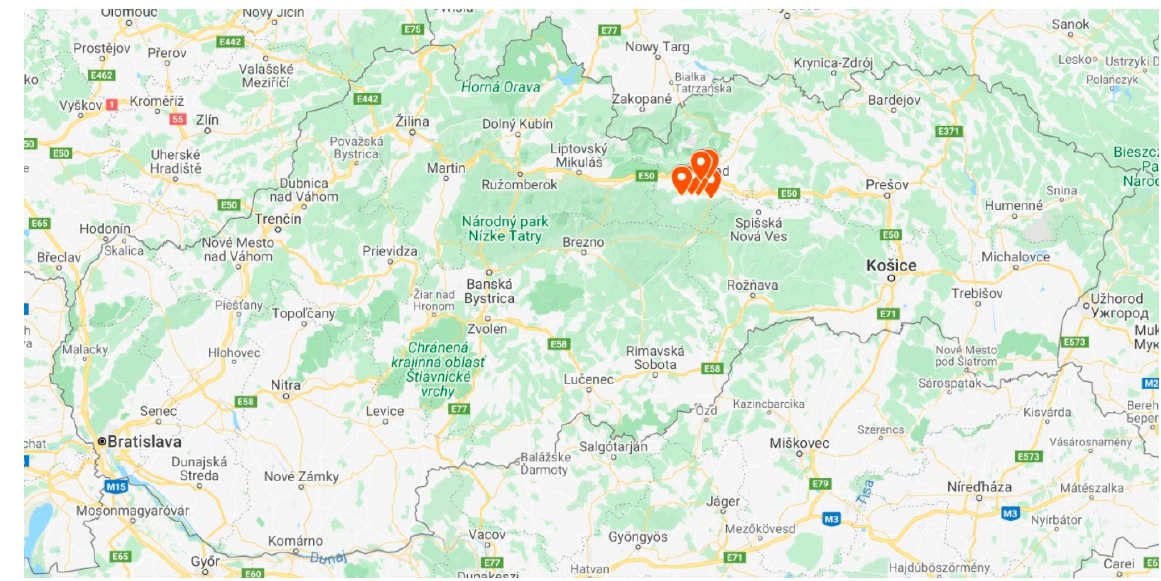
Figure 1. Slovakia, showing the Poprad district and research localities. Source: Google Maps, 2021 and the authors.